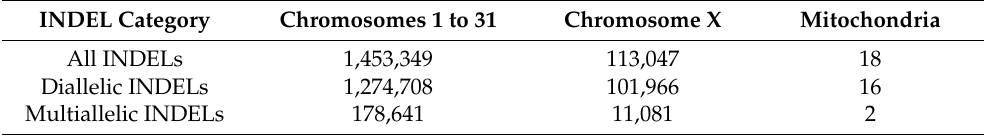
Table 1. The number of INDELs detected in 101 Thoroughbred racehorses.